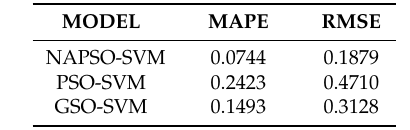
Table 2. Comparison of the index value among the three models (case 1).